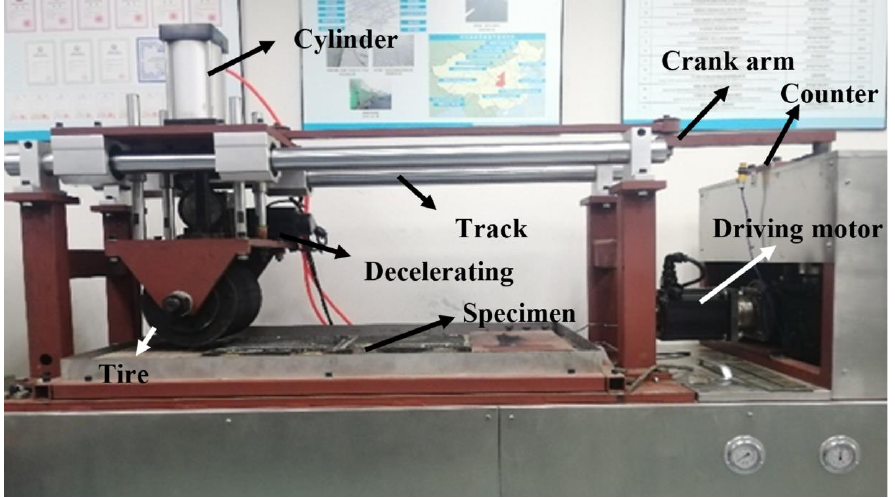
Figure 2. Multiple-accelerated abrasion machine [21].